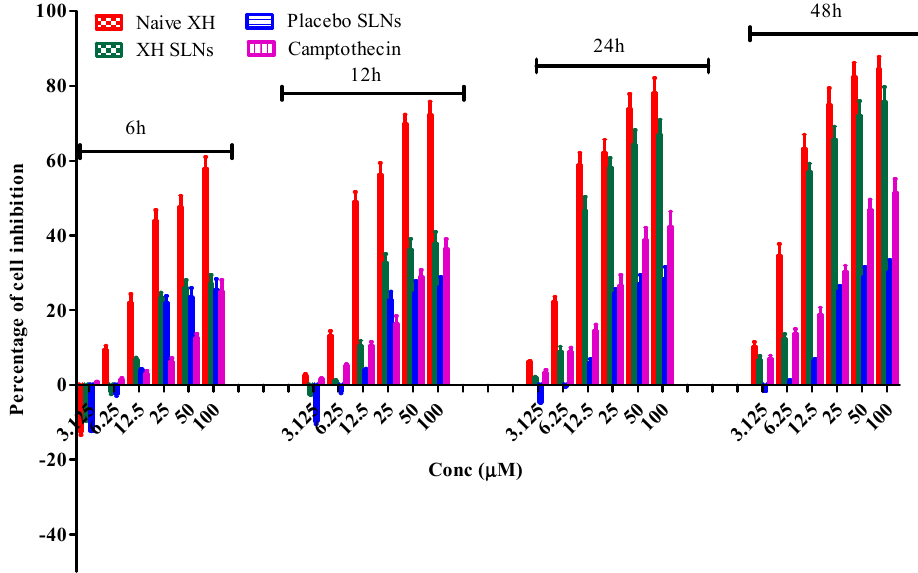
Figure 12. Results of PC-3 cell line % cell inhibition by naive XH, XH-SLNs, placebo SLNs and camptothecin (positive control).